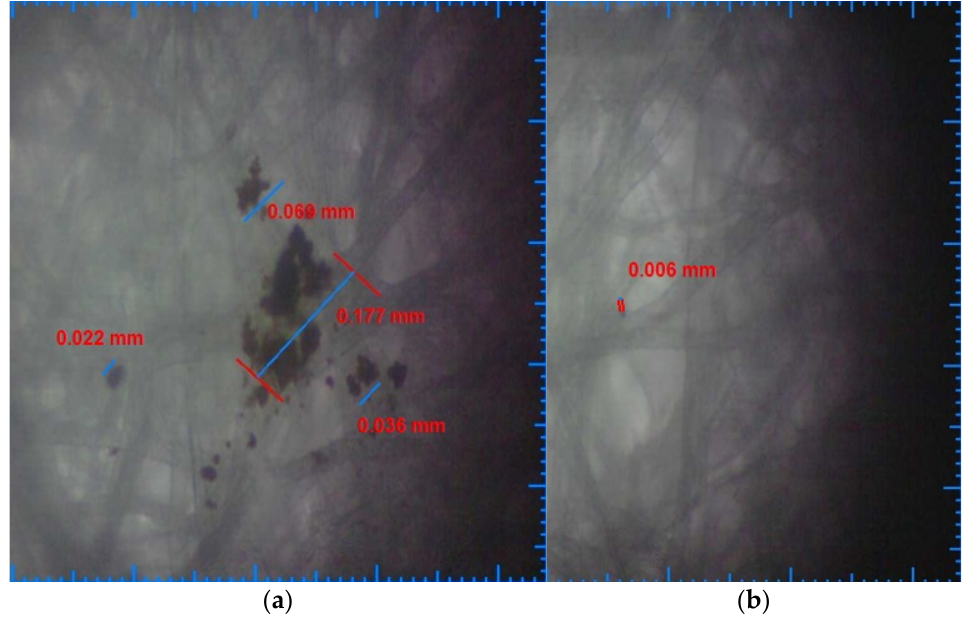
Figure 4. ( a ) Unfiltered water deposits sample; ( b ) ceramic filter water deposits sample.